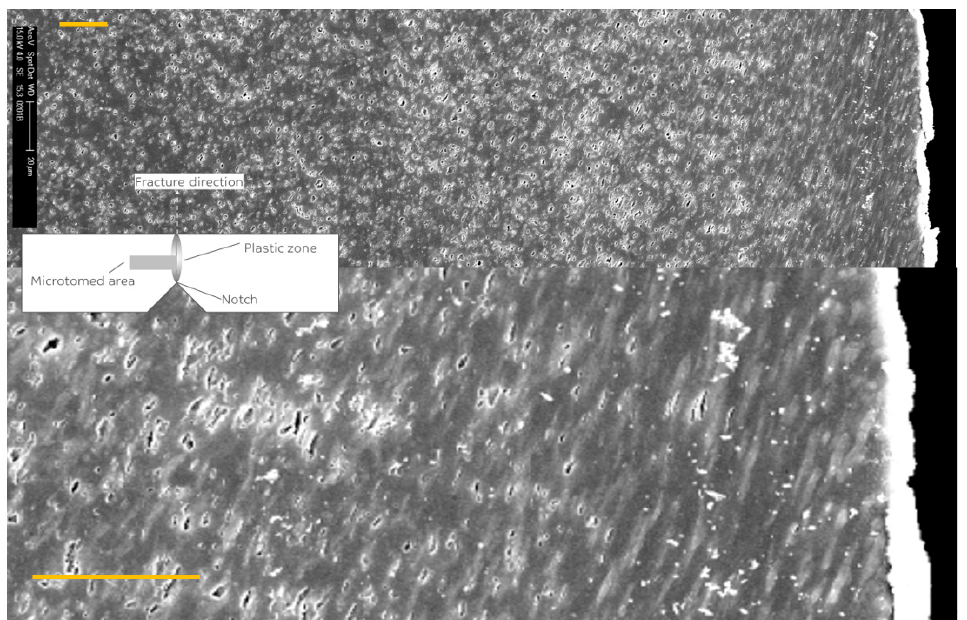
Figure 4. Scanning electron microscopy (SEM) micrograph of a perpendicularly microtomed and RuO 4 stained Izod bar revealing the deformation mechanism in the plastic zone after impact failure in a typical PP impact copolymer with 30 wt % rubber. The crack surface is on the right side and crack propagation went from bottom to top. The lower image is a magnification of the crack area. The two white lines represent 20 μ m.